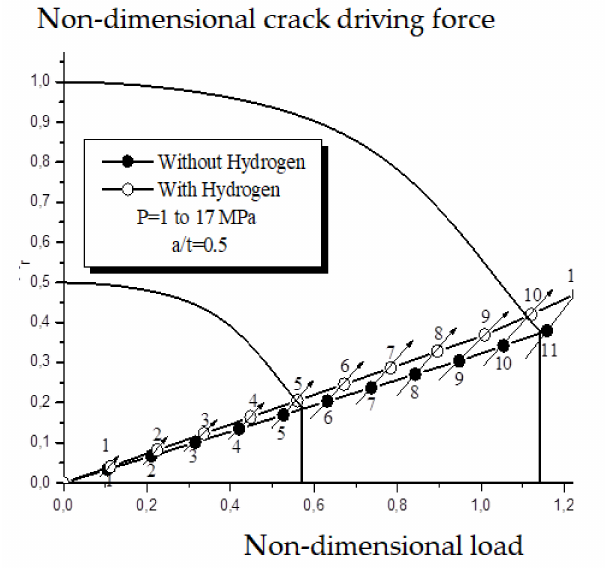
Figure 14. Two loading paths with and without HE; API 5L X52 steel, internal pressures: 1 and 17 MPa. Pipe diameter D = 611 mm and thickness t = 11 mm, relative defect depth